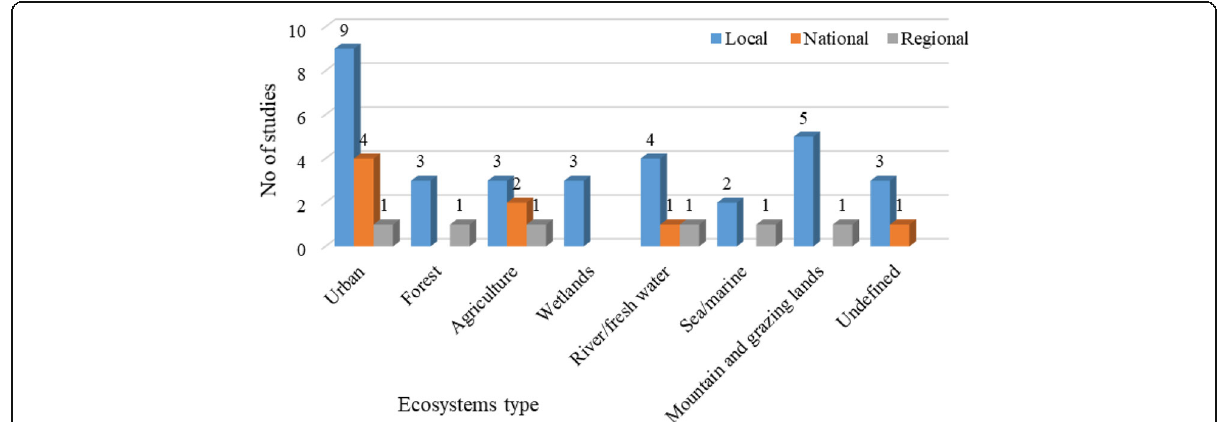
Fig. 4 The number of studies across scale levels and ecosystems